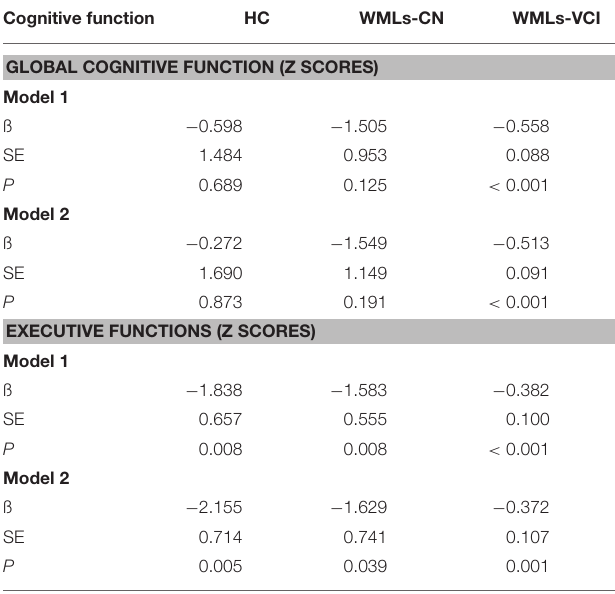
TABLE 3 | Associations between the peak width of skeletonized mean diffusivity and cognitive performance. Cognitive function WMLs-CN